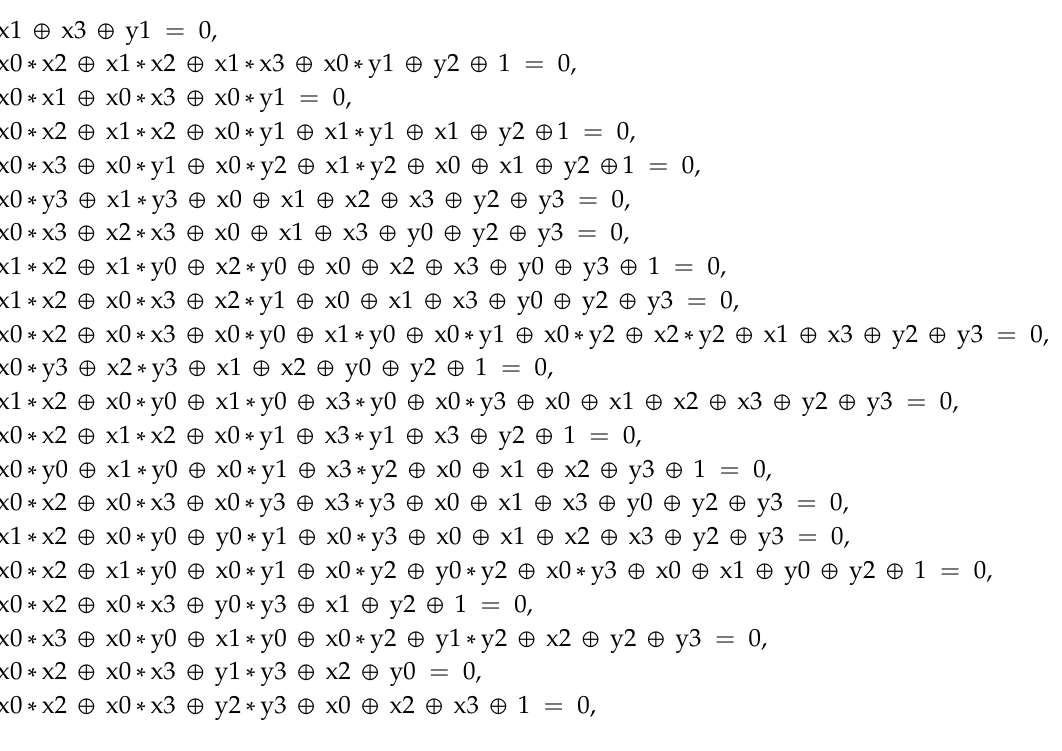
Figure 7. Dependences between the total computation time of the algebraic analysis and the numbers